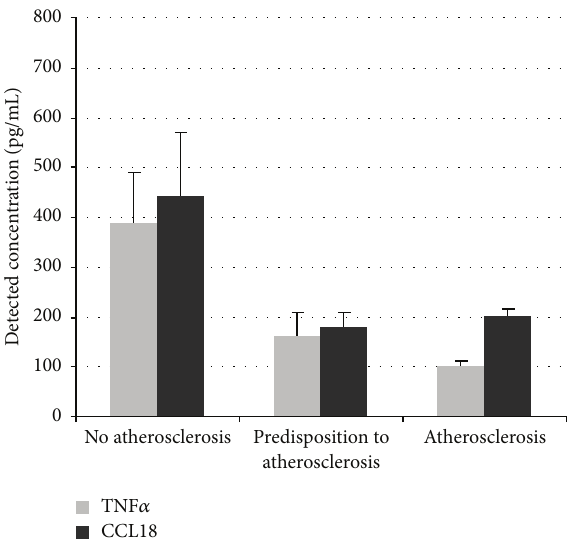
Figure 3: Study of monocyte/macrophage activation in subclinical and clinical atherosclerosis. Monocytes were isolated fromtheblood of subjects from 3 study groups ( 𝑛 = 20 in each group). Cells were stimulated with IFN- 𝛾 (100ng/mL) or IL-4 (10ng/mL). Secretion of TNF 𝛼 and CCL18 was measured by ELISA.